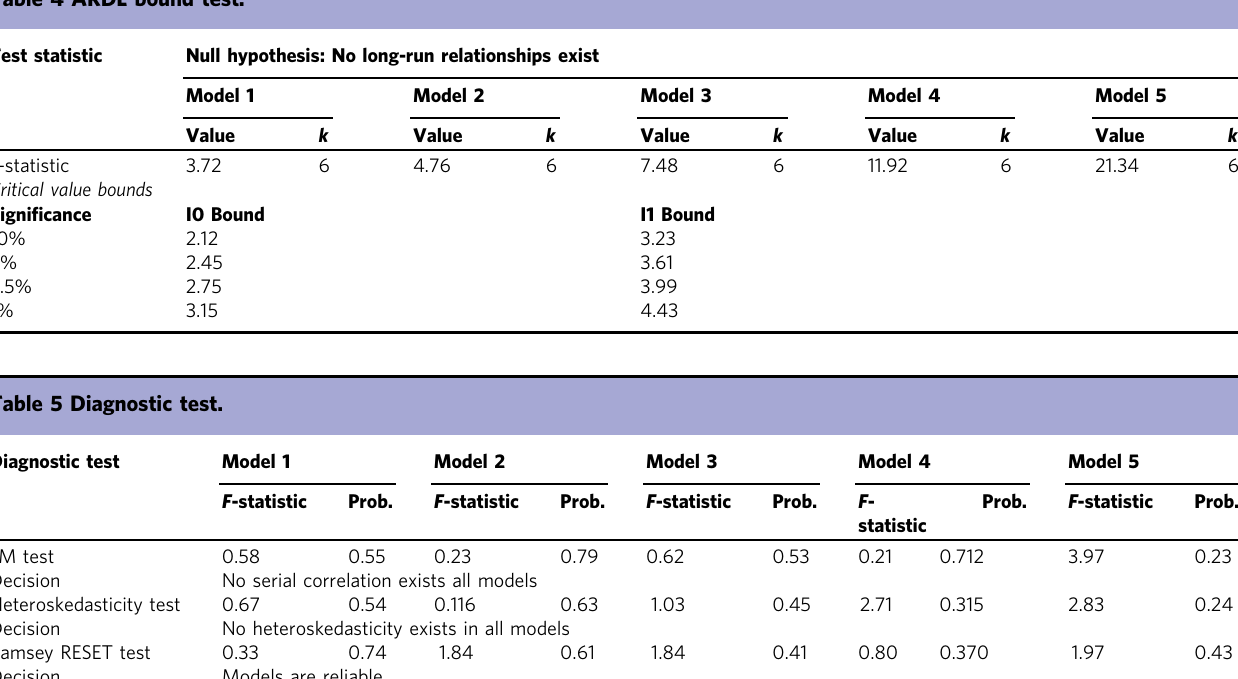
Table 4 ARDL bound test.